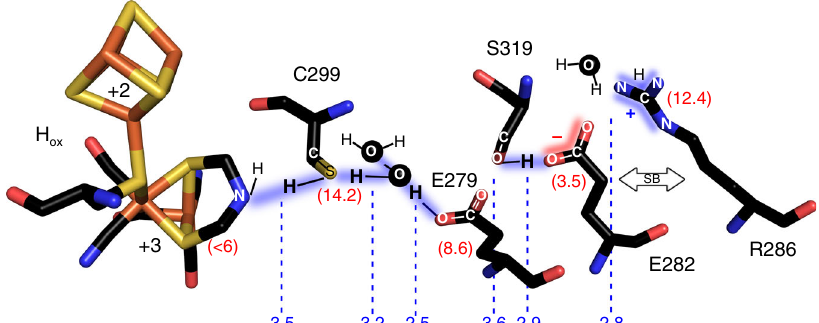
Fig. 5 Hydrogen-bonding pattern in the catalytic PT pathway of the H ox state. H-bond pattern of H ox according to p Ka values of the residues calculated for the structure of wild-type CpI (4XDC 19 ) via PROPKA 41 (see red numbers in parentheses). The p Ka of the adt-ligand in H ox is derived from a previous study 58 . The blue numbers indicate the distances between neighboring positions of the PT pathway. The arrow labeled “ SB ” indicates a presumptive salt bridge contact between R286 and deprotonated